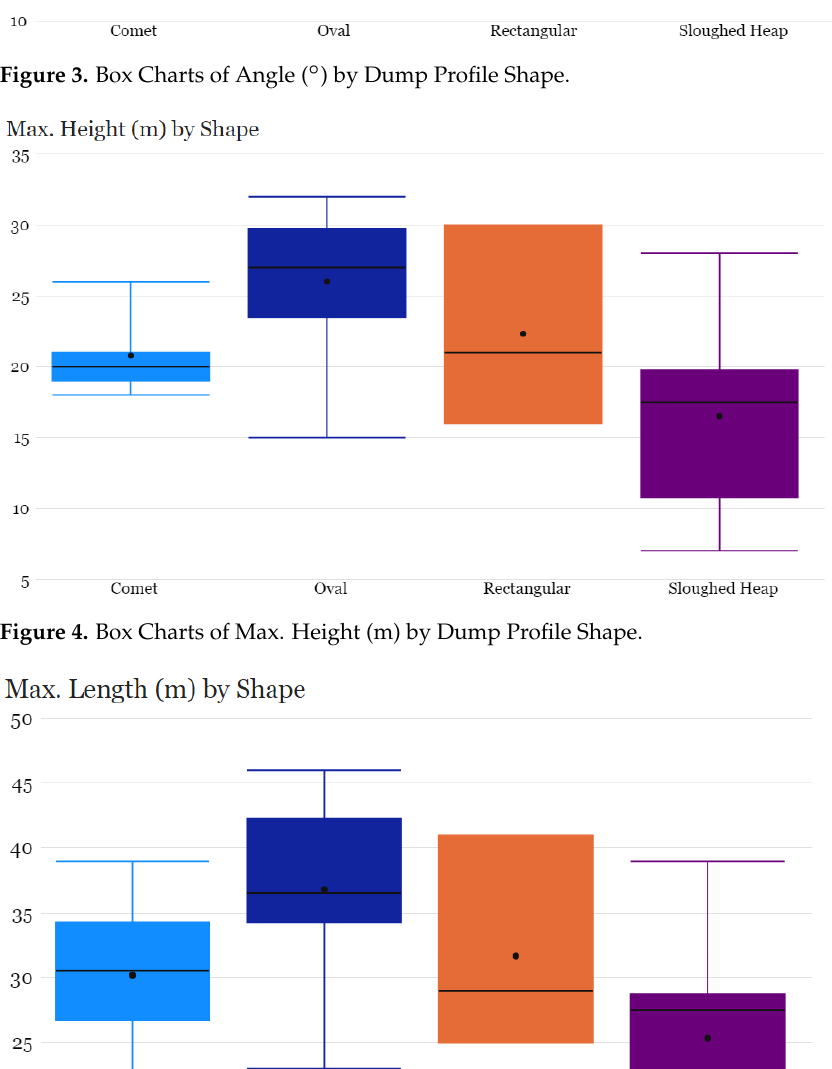
Figure 3. Box Charts of Angle ( ° ) by Dump Profile Shape.